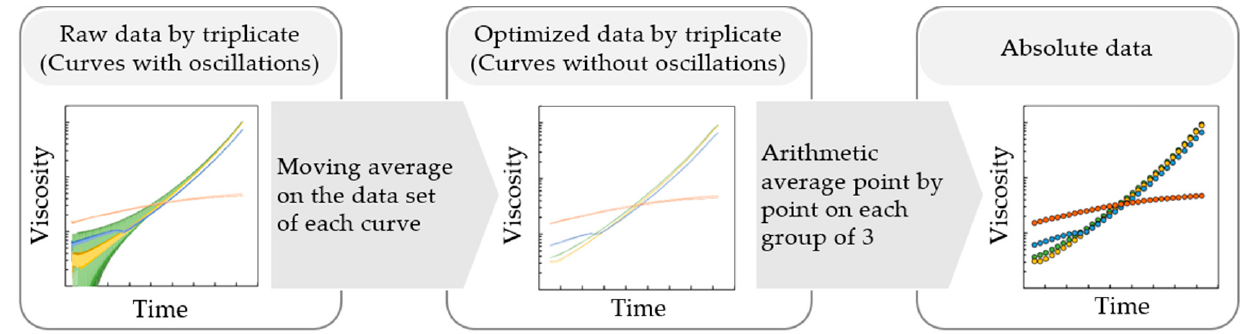
Figure 2. Protocol for the rheological data processing at various shear rates, starting from low viscous mixtures that are reacting and becoming more viscous. The figure shows an example of the raw oscillatory data ( left ), then the moving average step that yields optimized data ( center ), and finally the arithmetic average step that yields the absolute data ( right ) per shear rate value.